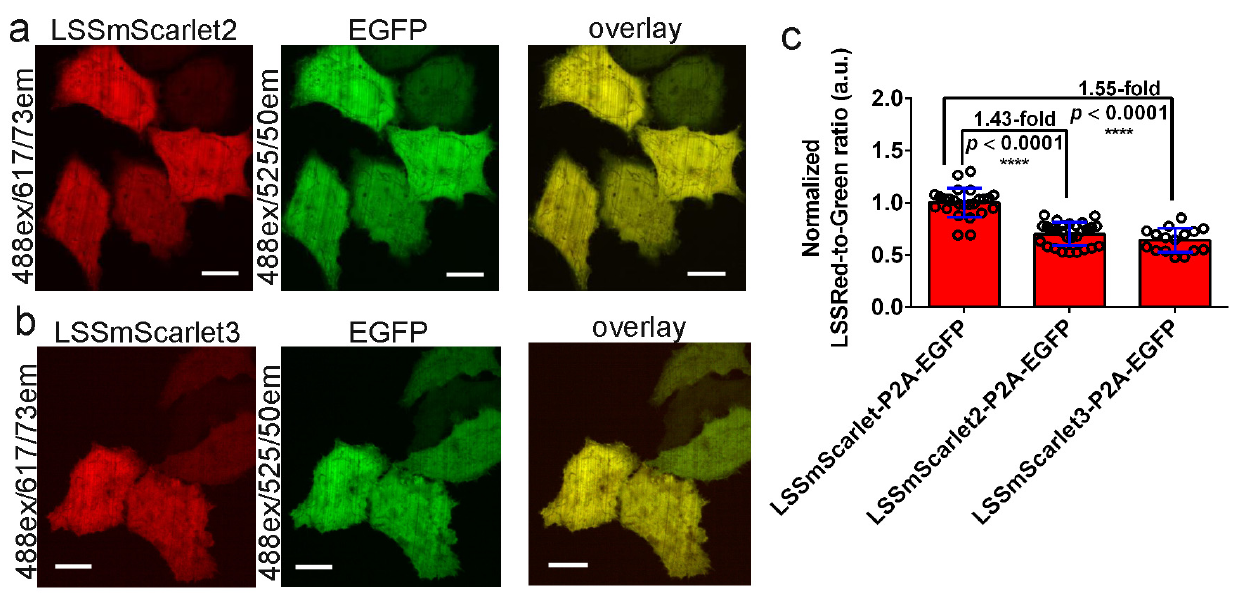
Figure 7. Comparison of the brightness of the LSSRFPs in the cytosol of HeLa cells. ( a , b ) Confocal images of HeLa cells expressing the LSSmScarlet2-P2A-EGFP ( a ) or LSSmScarlet3-P2A-EGFP ( b ) proteins. LSSRed (488 ex and 617/73 em, in red color) and green (488 ex and 525/50 em, in green color) fluorescence channels and their overlay are shown. Scale bar, 50 µm. ( c ) The averaged brightness for the LSSRFPs in HeLa cells normalized to the brightness of the EGFP expressed in the same cells. The EGFP is connected to LSSRFPs via a P2A-self cleavable linker. The error bars are the standard deviations across sixteen to twenty-eight cells. The p values show significant dif- ferences between the respective values. ****, p value is <0.0001.